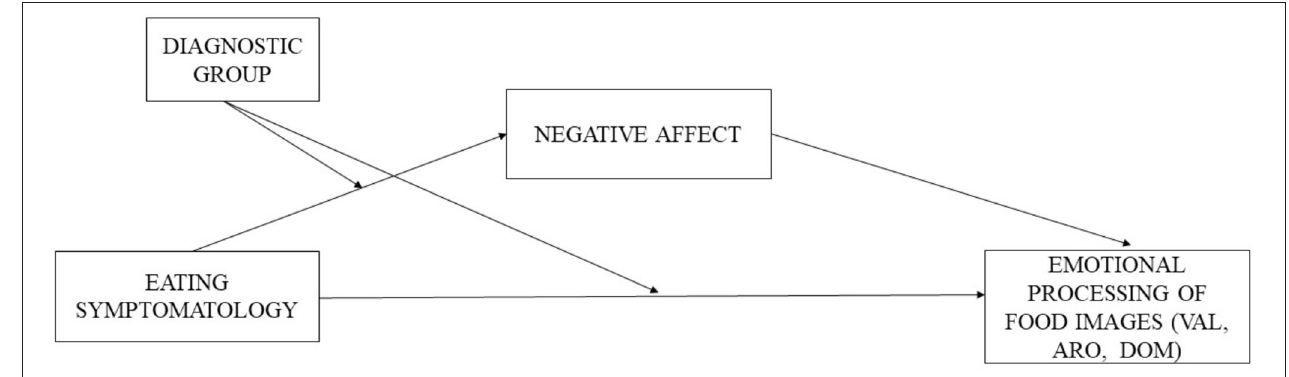
FIGURE 1 | Mediation model with group moderation (ED patients vs. non-ED patients) between the direct effect of eating symptomatology on emotional processing of food images (valence, arousal, and dominance) and between the indirect effect through negative affect. VAL, Valence; ARO, Arousal; DOM, Dominance.